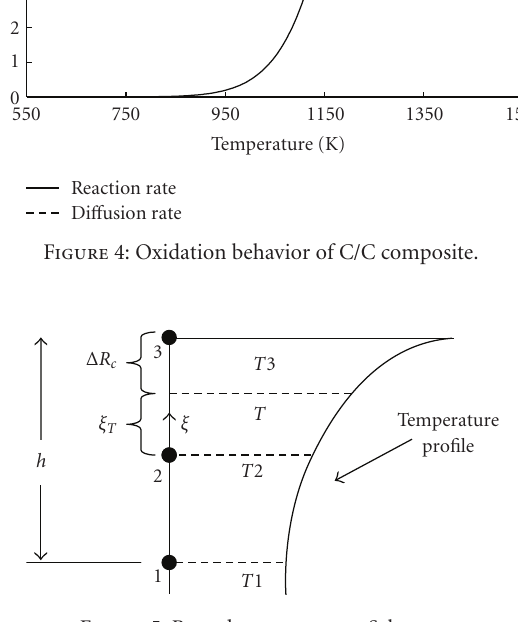
Figure 5: Boundary movement